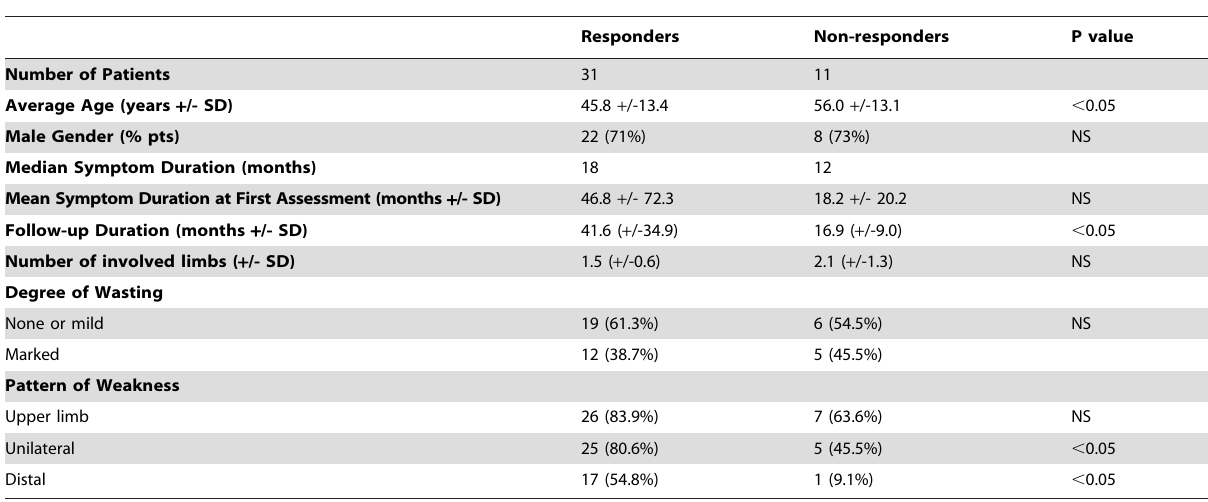
Table 1. Demographic and clinical characteristics.